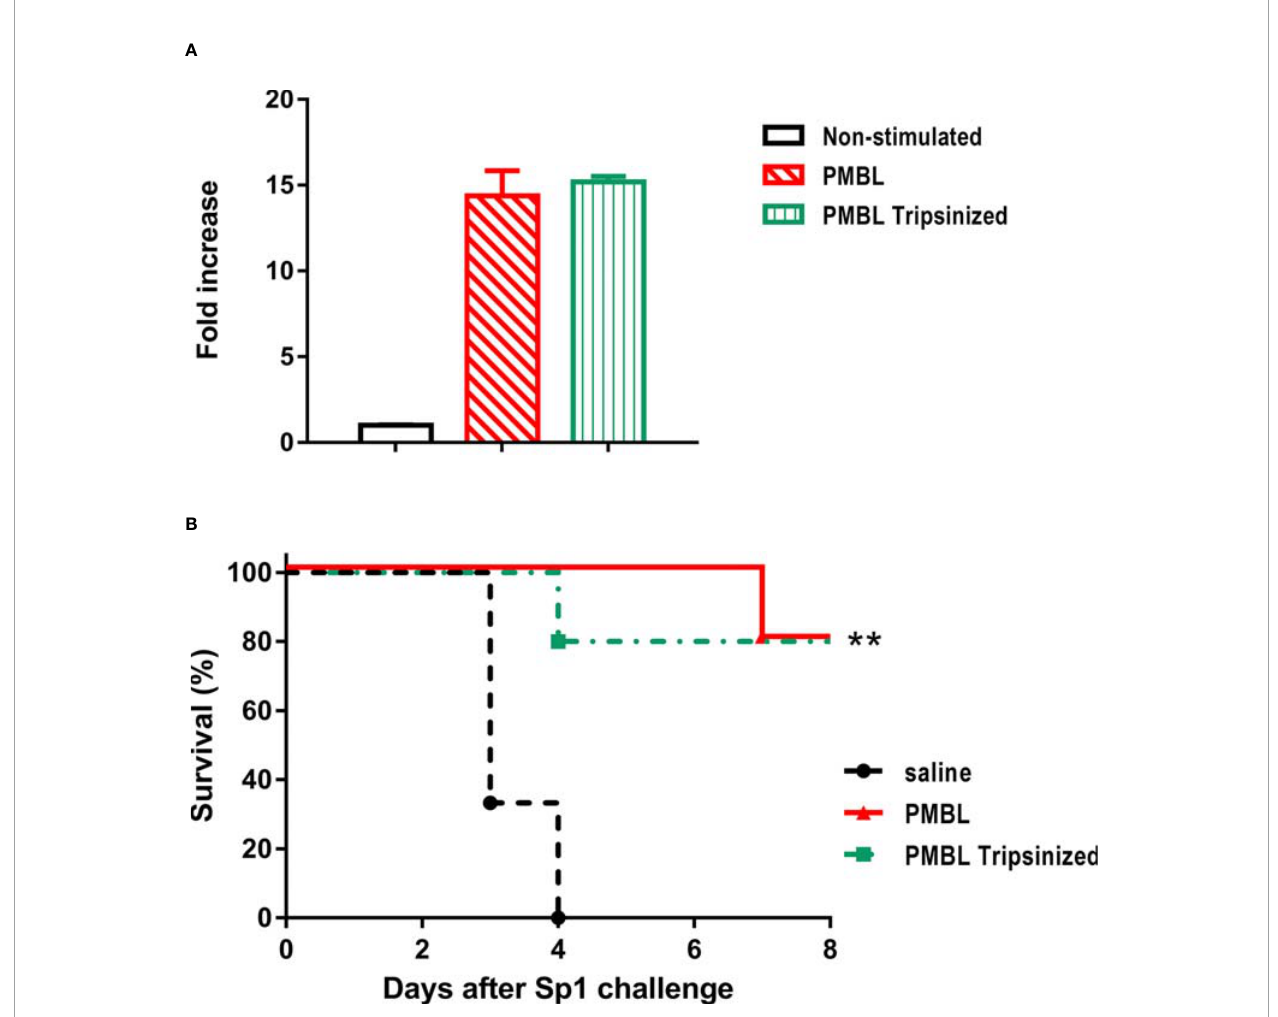
FIGURE 7 | (A) In vitro stimulation of Raw-Blue cells with equivalent amounts of PMBL (10 m g/ml) or trypsinized PMBL. Supernatants were taken 24 h later and SEAP reporter levels were measured by the QUANTI-Blue method (O.D. 638 ). The bars represent Mean ± SEM of triplicate cultures for fold increase related to non- stimulated.Data are representative of three independent experiments. (B) Survival rates from lethal pneumonia challenge (Sp1) of mice (n=6) that were pretreated i.n. with same quantities (18 µg/30 µl) of PMBL and Trypsinized PMBL. All mice were challenged 24 hours later with the MLD of Sp1 (3x10 6 CFU/50 µl). Survival rates for each group were recorded for 8 days. Signi fi cant differences are shown by **p < 0.001, treated vs. untreated, Log-rank test (Mantel-Cox). Data are representative of three independent